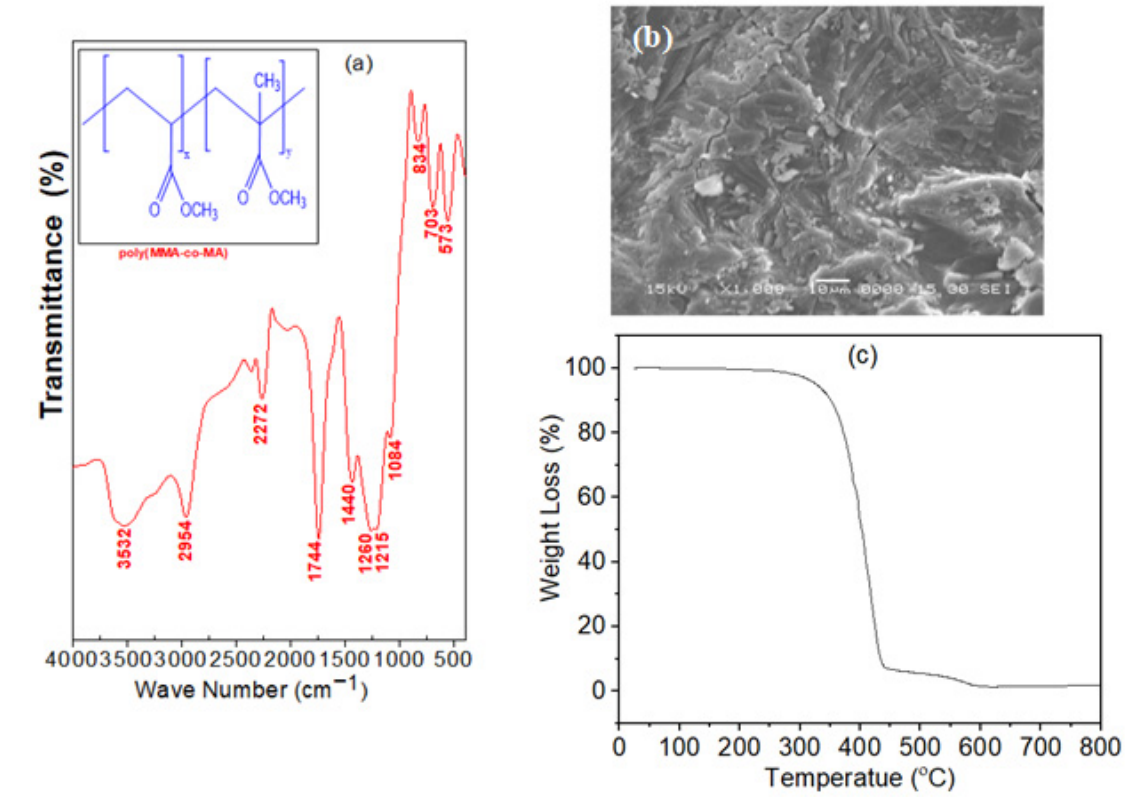
Figure 10. ( a ) FTIR spectra, ( b ) SEM, and ( c ) TGA of poly (MMA- co -MA) membrane.